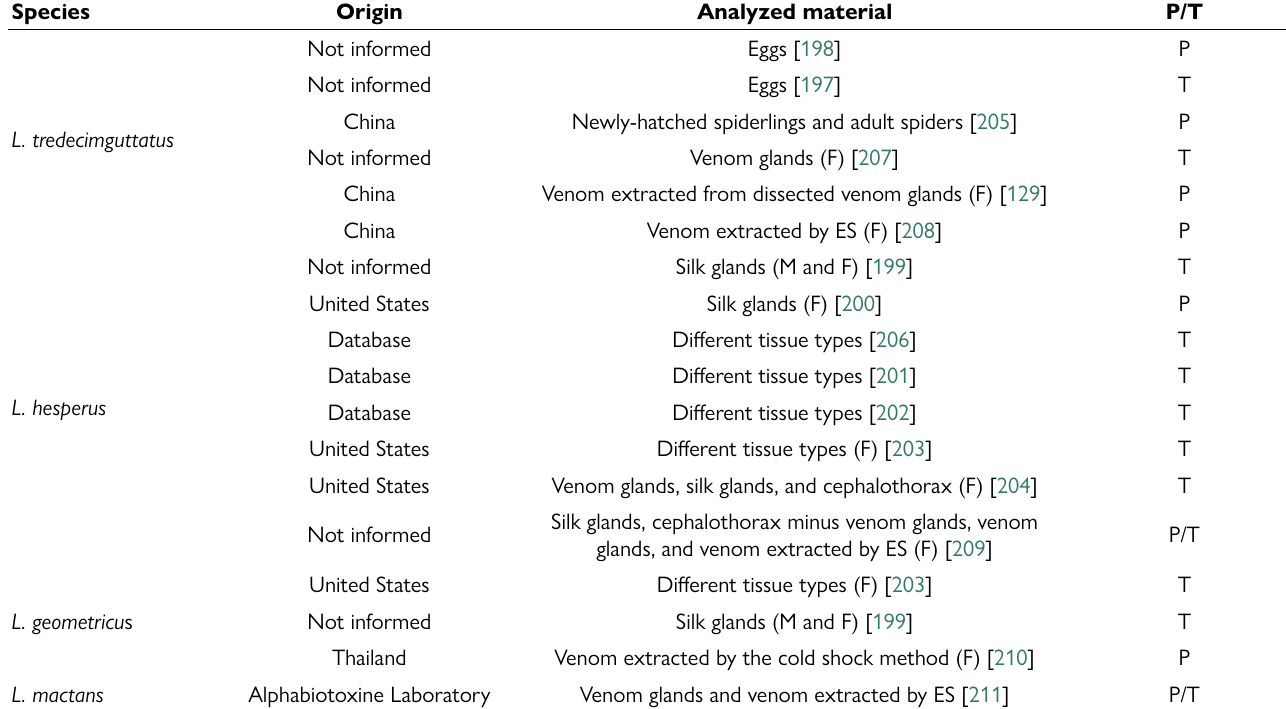
Table 3. Compilation of the studies on Latrodectus spiders using proteomics and transcriptomics approaches.